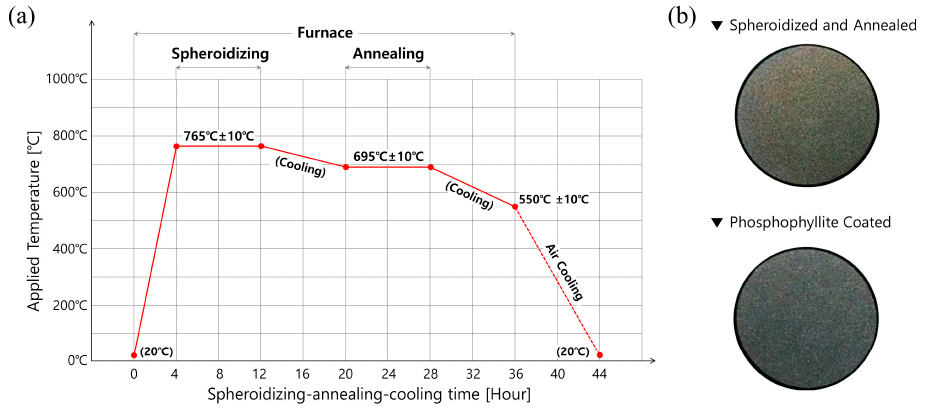
Figure 2. ( a ) Time–temperature history of spheroidizing and annealing, and ( b ) heat-treated and phosphophyllite-coated AISI 1035 medium carbon steel